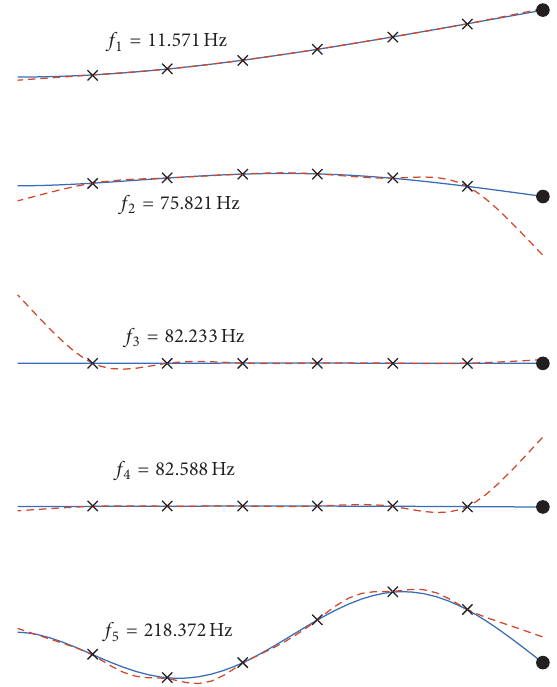
Figure 10: Mode shapes of cabled beam with 6 connections when = 10 5 𝑘 𝑙